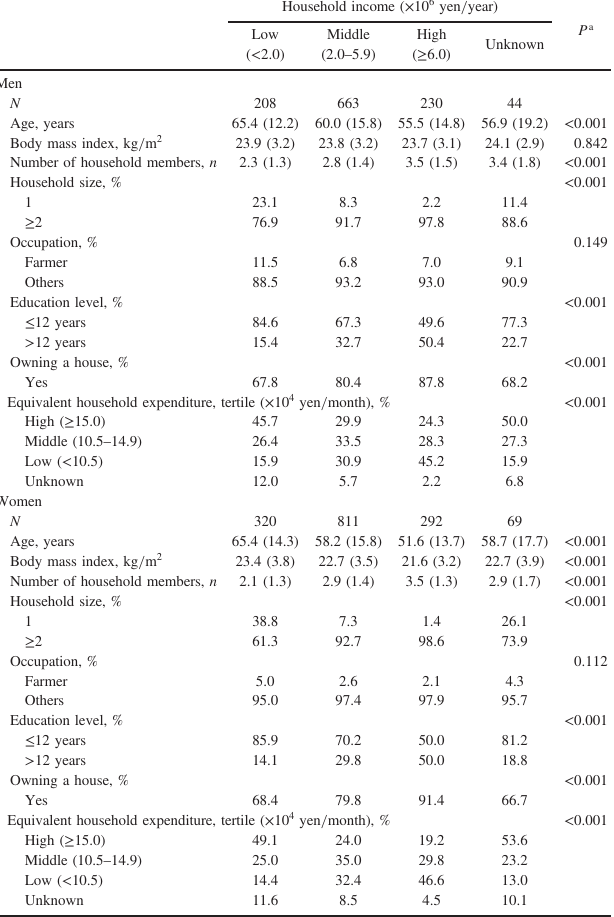
Data are n , mean (standard deviation [SD]), or %. a One-way ANOVA for continuous variables and χ 2 test for categorical